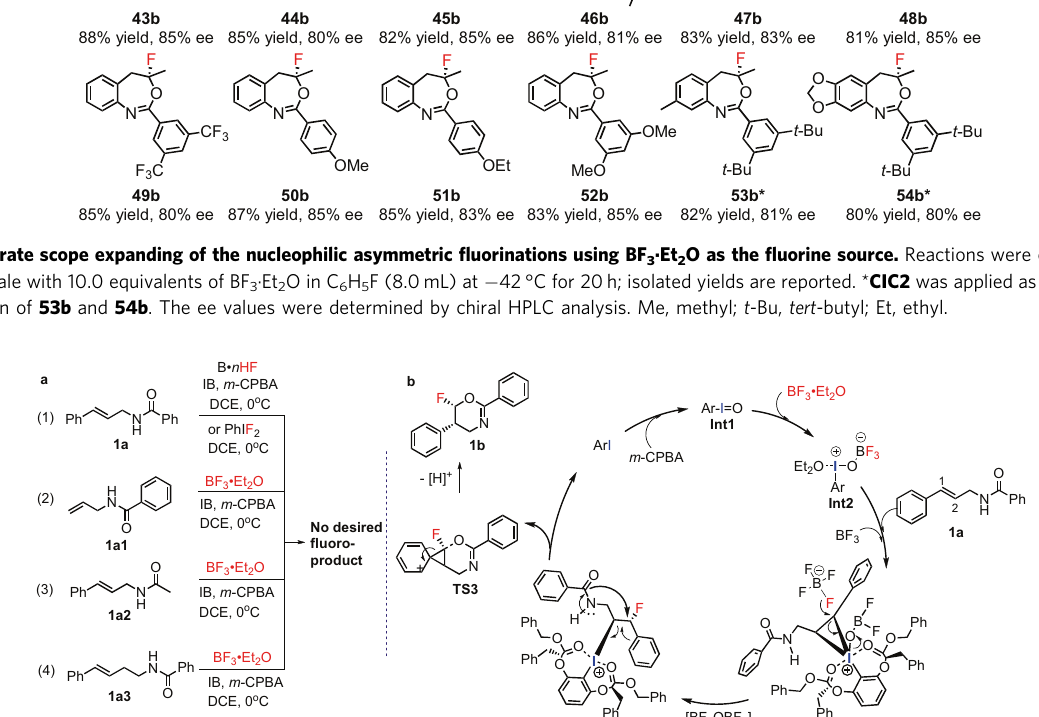
(Fig. 5b) 49 , which was calculated to be + 11.1 kcal/mol in energy relative to Int4 + . And then Int5 is formed with 1.7 kcal/mol of energy barrier relative to TS2 . The hypervalent iodine (III) Int5 underwent reductive elimination to afford Int6 with 6.8 kcal/mol of energy barrier. TS3 was formed by the intramolecularly nucleophilic attack of the amide oxygen on C 2 position with 4.5 kcal/mol of energy barrier relative to Int6 . Here the nucleophilic attack of the amide oxygen takes place regioselectively at the higher substituted carbon atom of the cyclopropane unit 49 . Ring opening of the spirocyclopropyl ring TS3 takes place intramo- lecularly via a cyclization with simultaneous ring expansion to the six-membered cationic Int7 (Fig. 6) 49 . The calculated energy barrier for this step is − 38.9 kcal/mol relative to TS5 . Control experiment (Fig. 5a, equation 2) demonstrated the necessity of Ar 1 ring. Moreover, the aromatic ring (Ar 2 ) is essential to stabilize cationic Int7 ( Fig. 5a, equation 3). With the assistance of [BF 2 OBF 3 ] - anion, Int7 can be deprotonated to generate fi nal product 1b (Fig. 6a). Besides, lengthening of carbon chain could not result in a desired fl uoro-product according to the control experiment (Fig. 5a, equation 4). In a word, the formation of fl uorinated oxazines follows a fl uorination/1, 2-aryl migration/ cyclization cascade 49 .